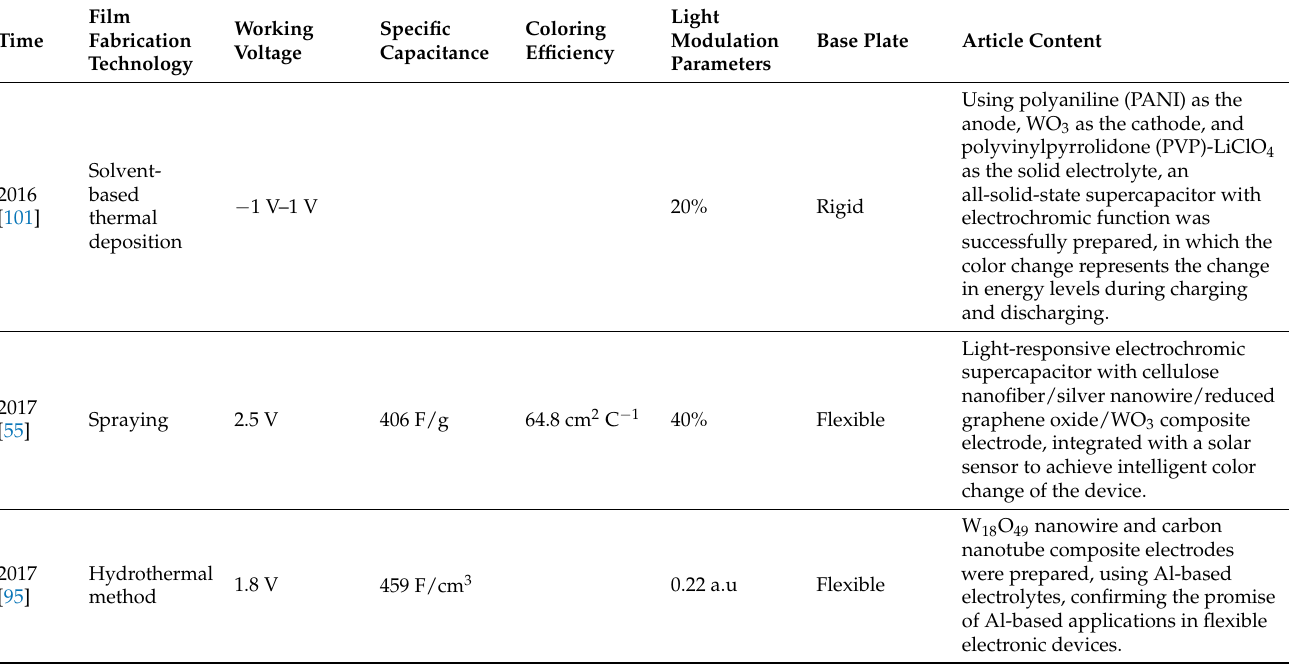
Table 1. Relevant tungsten oxide ECSC reports in recent